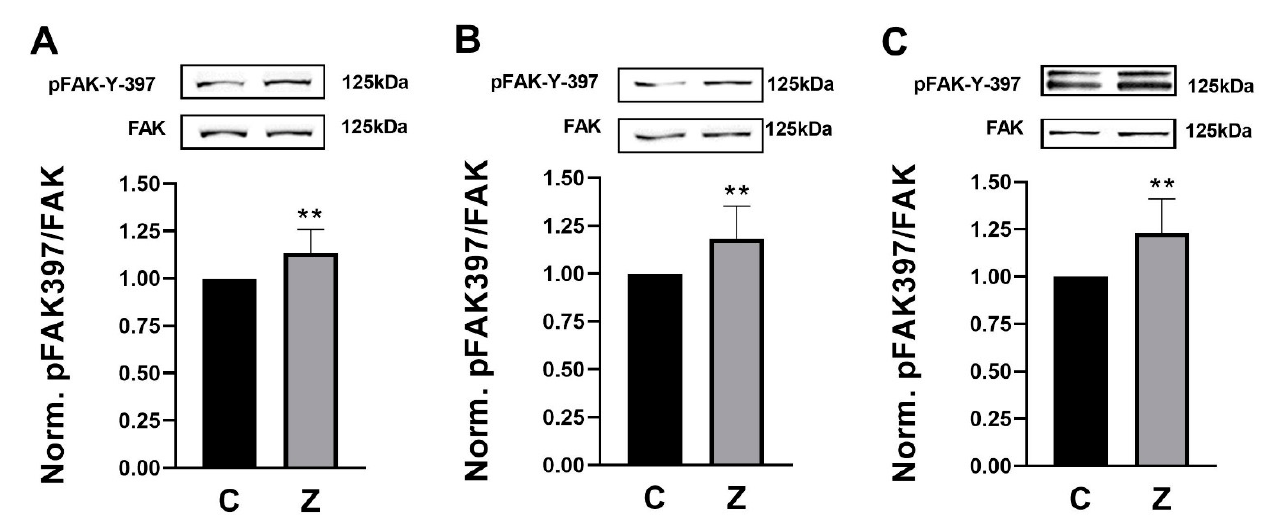
Figure 1. ZINC40099027 (ZN27) activates focal adhesion kinase (FAK) in rat (RGM1) and human (AGS and NCI-N87) gastric epithelial cells. Gastric epithelial cells were treated with 0.05% DMSO as a vehicle control or with 10 nM ZN27 for one hour. Total FAK served as a loading control. ( A ) Representative blots and FAK-Y-397/FAK fold change in RGM1 cells ( n = 12, ** p < 0.01). ( B ) Representative blots and FAK-Y-397/FAK fold change in AGS cells ( n = 10, ** p < 0.01). ( C ) Representative blots and FAK-Y-397/FAK fold change in NCI-N87 cells ( n = 8, ** p < 0.01). Vehicle control–DMSO (C) and ZN27 (Z).